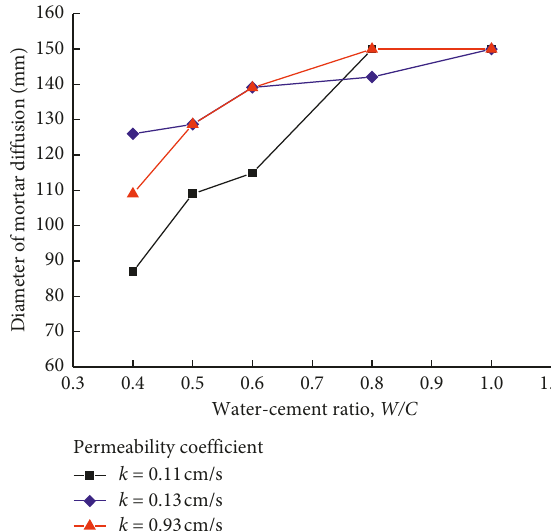
Figure 8: Characteristics of slurry diffusion ( P � 0.4MPa).